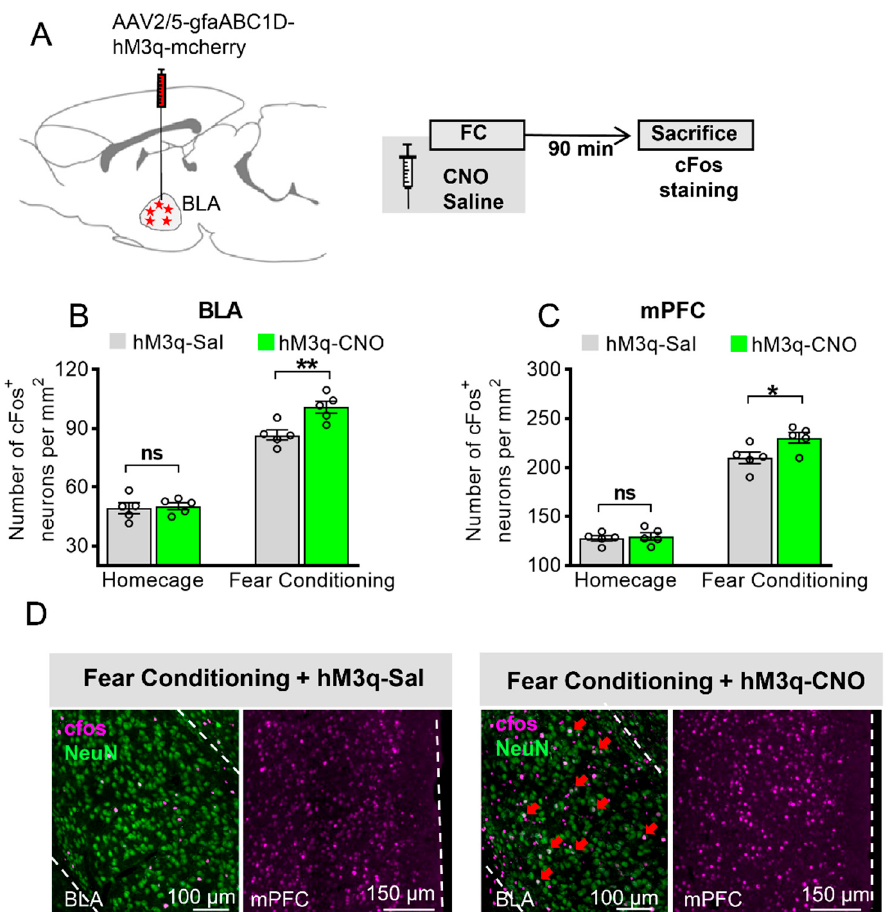
Figure 2. Astrocytic Gq activation increases c-Fos expression in the BLA and the mPFC in fear conditioning, but not in the home cage. ( A ) Schematic diagram for brain sample collection and c-Fos staining from mice injected with AAV2/5-gfaABC1D-hM3q-mcherry. ( B ) c-Fos level in BLA neurons of four-group mice expressing hM3q in their BLA astrocytes (n = 5 of each group, 5 slices for each mouse, two-way ANOVA with Bonferroni post hoc comparison test, main effect of Sal/CNO: F (1, 8) = 6.461, p = 0.0346, ‘homecage (HC) + hM3q-Sal’ versus ‘HC + hM3q-CNO’: p > 0.9999, ns stands for no significance, ‘fear conditioning (FC) + hM3q-Sal’ versus ‘FC + hM3q-CNO’: p = 0.0027, ** stands for p < 0.01, ns stands for no significance). ( C ) c-Fos level in mPFC neurons of four-group mice expressing hM3q in their BLA astrocytes (n = 5 of each group, two-way ANOVA with Bonferroni post hoc comparison test, main effect of Sal/CNO: F (1, 8) = 8.189, p = 0.0211, ‘HC + hM3q-Sal’ versus ‘HC + hM3q-CNO’: p > 0.9999, ns stands for no significance, ‘FC + hM3q-Sal’ versus ‘FC + hM3q-CNO’: p = 0.0127, * stands for p < 0.05). ( D ) Representative pictures of c-Fos (pink) expression in BLA neurons (NeuN, green) and mPFC under CNO or saline after fear conditioning, scale bar 100 μ m, 150 μ m. Red arrow shows the BLA neurons (NeuN) with c-Fos expression. All data are presented as mean ± SEM.